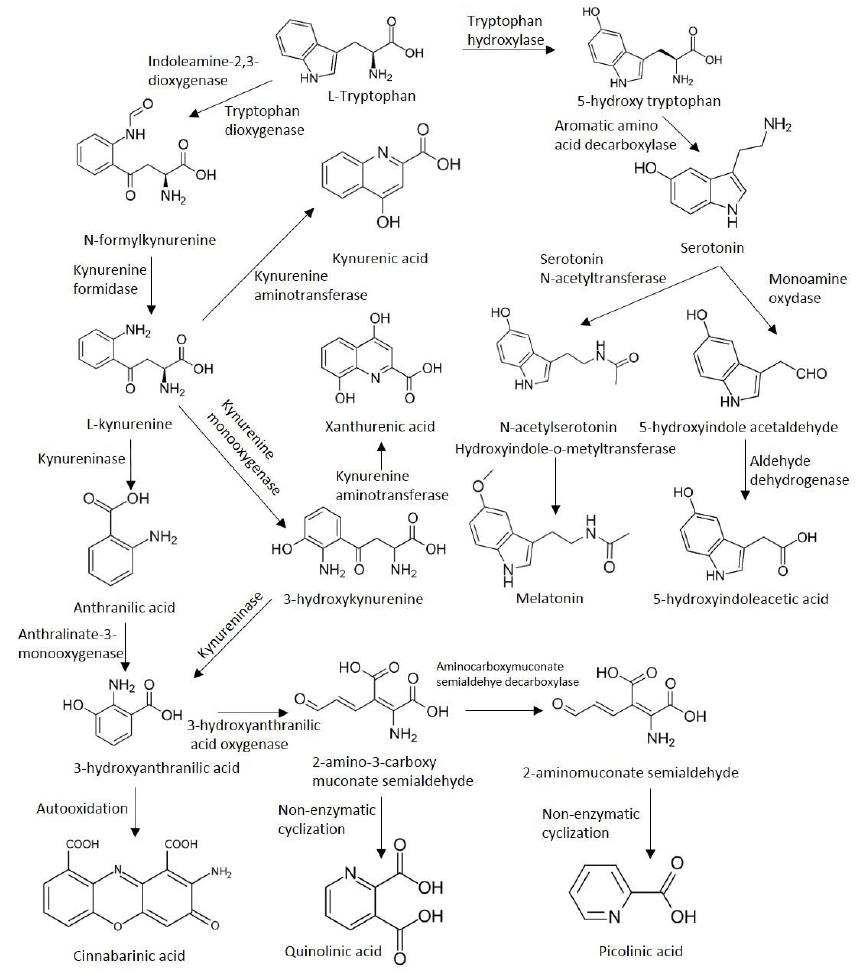
Figure 1. The kynurenine pathway of tryptophan metabolism.